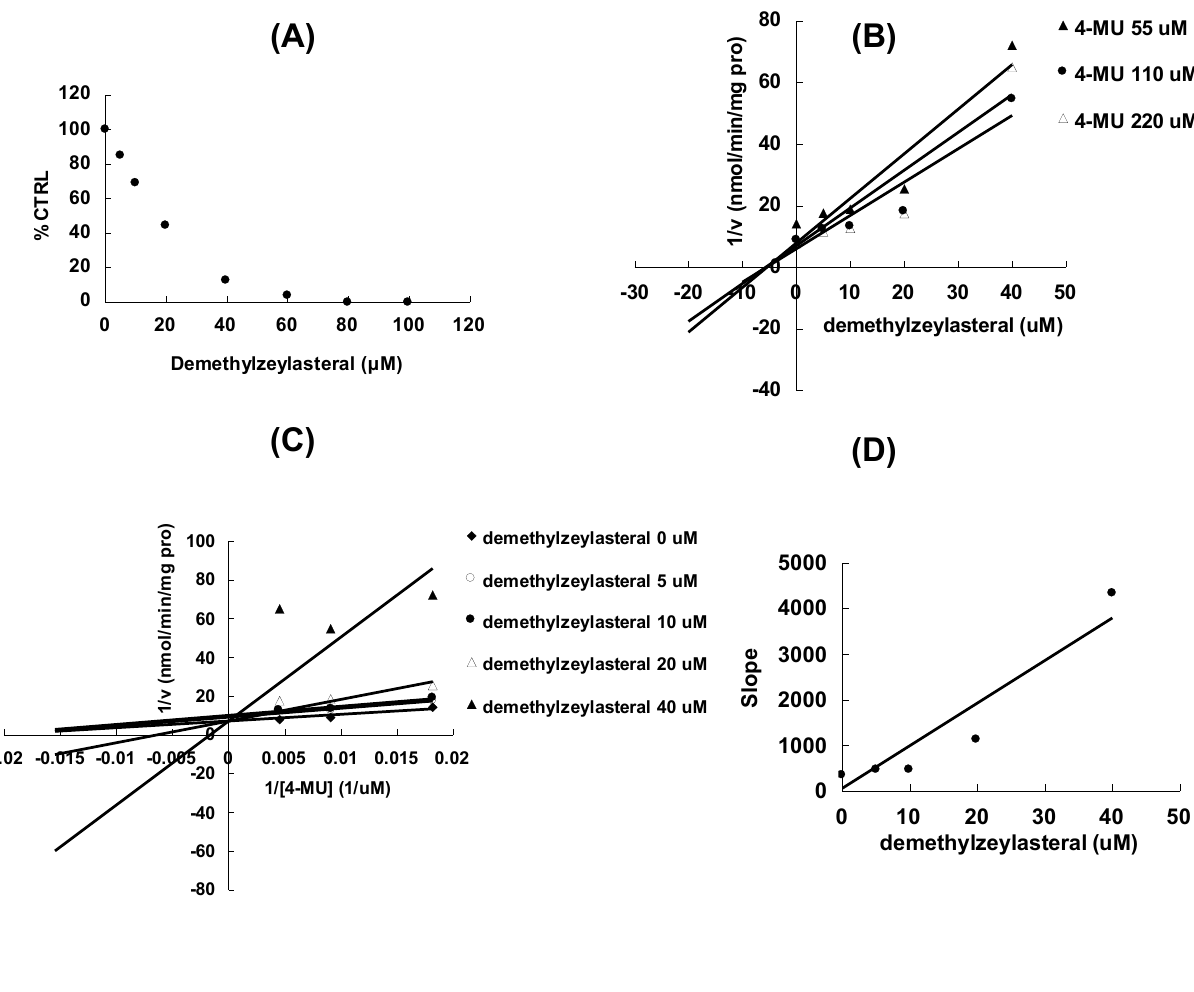
Figure 2. Inhibition kinetic analysis of demethylzeylasteral towards recombinant UGT1A6-catalyzed 4-MU glucuronidation. ( A ) Demethylzeylasteral showed dose-dependent inhibition towards UGT1A6; ( B ) Dixon plot of demethylzeylasteral inhibition towards UGT1A6-catalyzed 4-MU glucuronidation; ( C ) Lineweaver-Burk plot of demethylzeylasteral inhibition towards UGT1A6-catalyzed 4-MU glucuronidation; ( D ) Second plot using slope (obtained from Lineweaver-Burk plot) vs. the concentration of